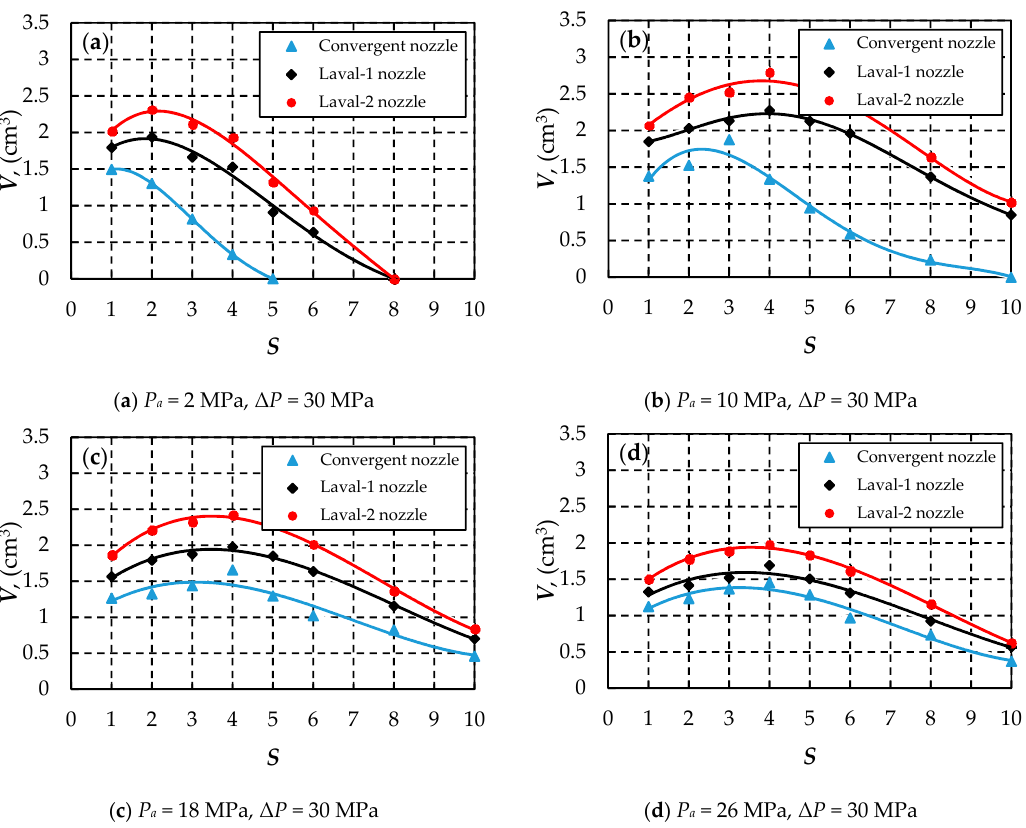
Figure 8. Effect of nozzle configuration on rock erosion volume of the SC-CO 2 jet under different ambient pressures and constant Δ P : ( a ) 2 MPa; ( b ) 10 MPa; ( c ) 18 MPa; ( d ) 26 MPa.